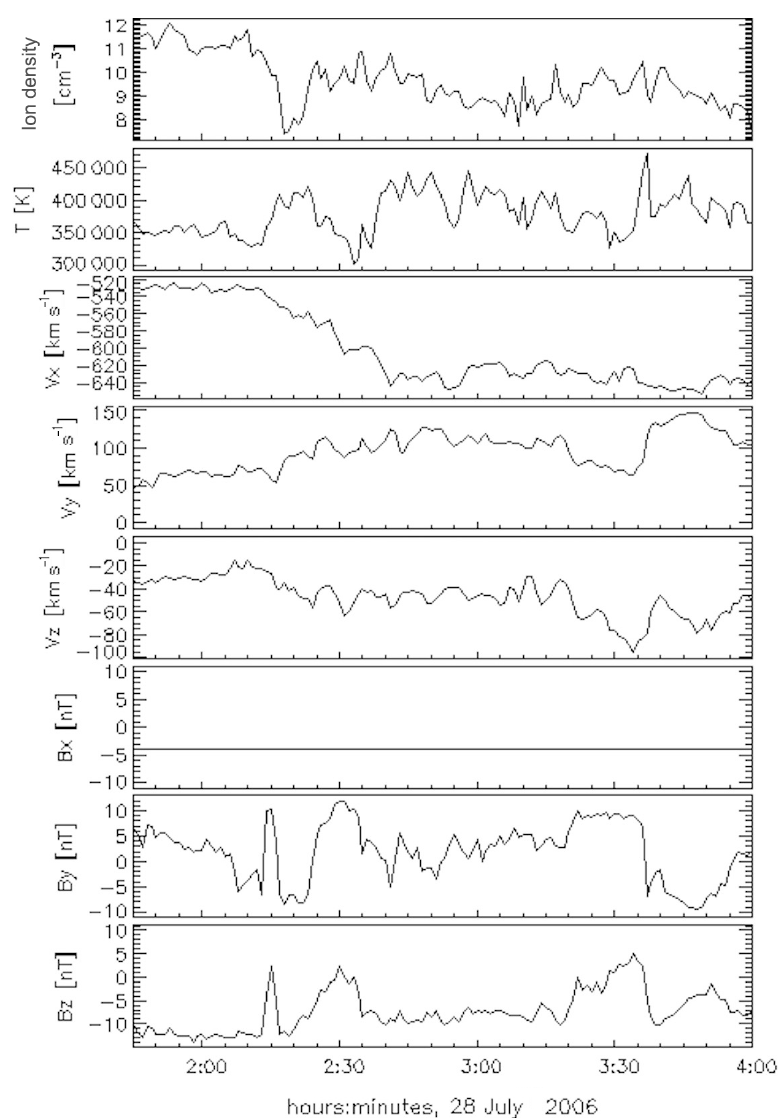
Figure 3. Solar wind conditions used for the MHD simulation used by Hwang et al. (2011). It shows the ion density, temperature, vx , vy , vz , Bx , By and Bz